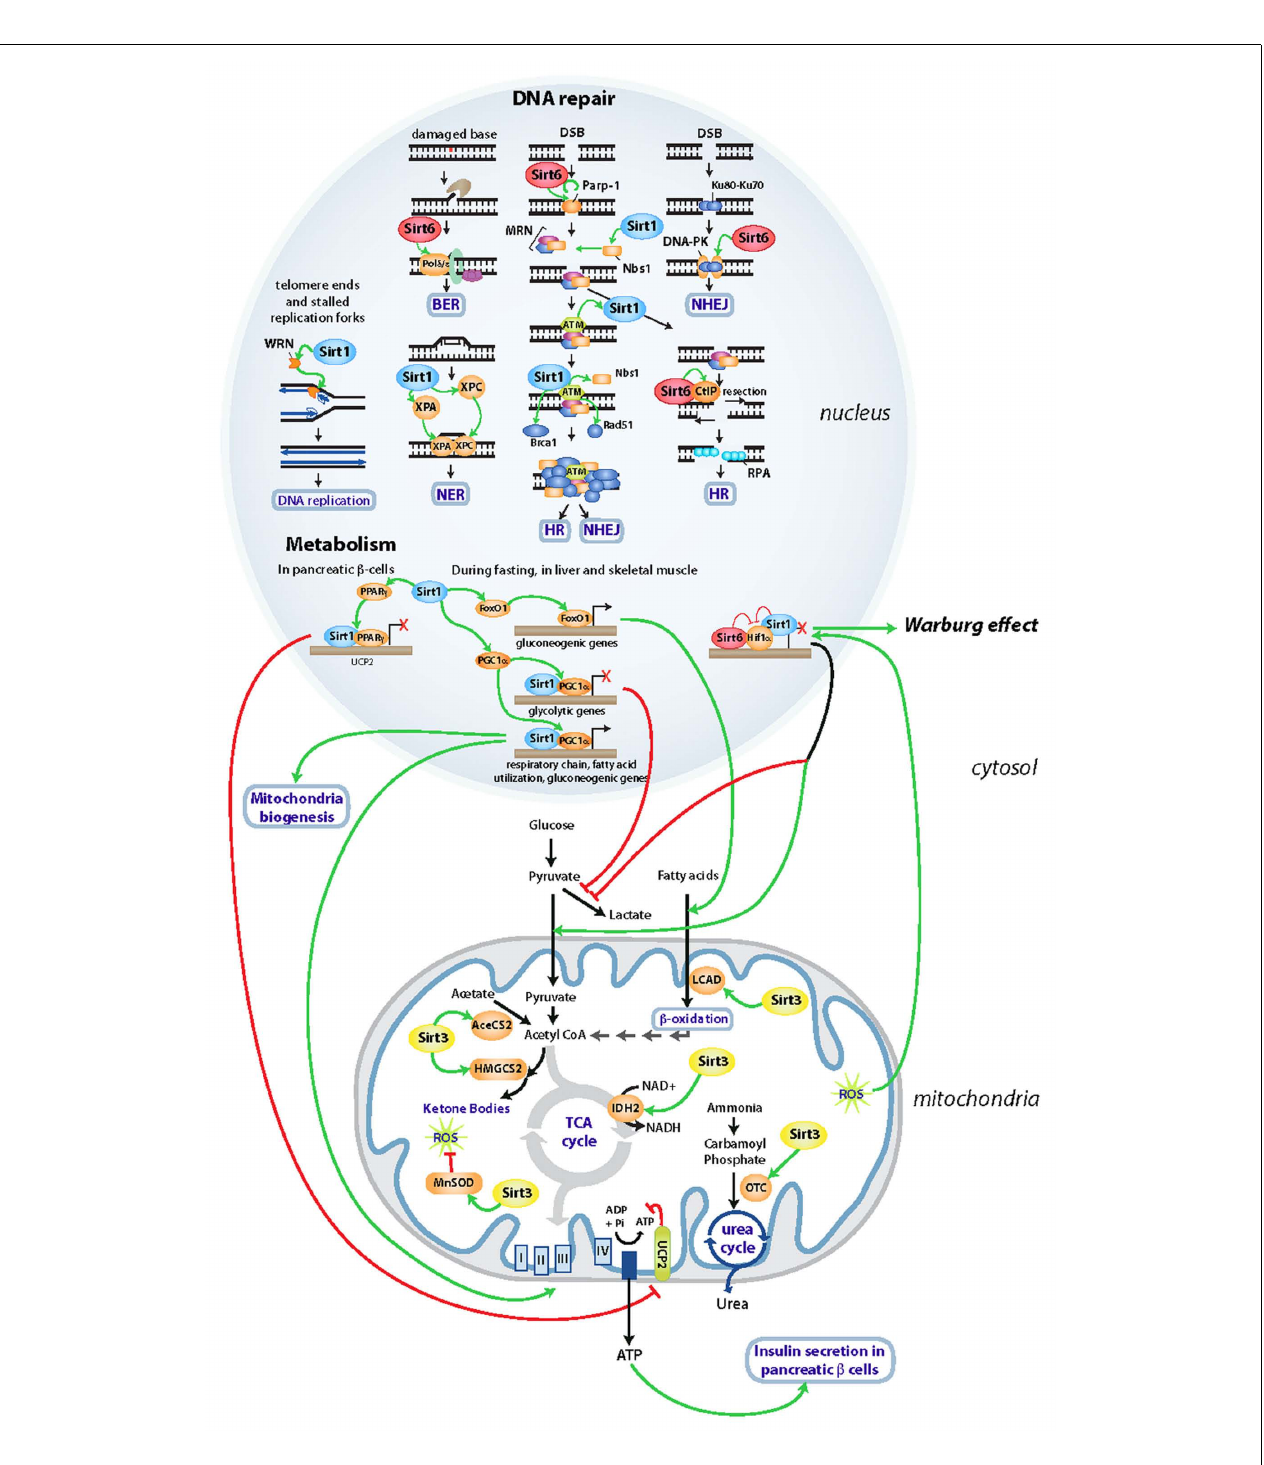
FIGURE 1 | Sirtuins’ regulation of DNA repair and metabolism. Diagram indicating the main DNA repair and metabolic pathways regulated by SIRT1,